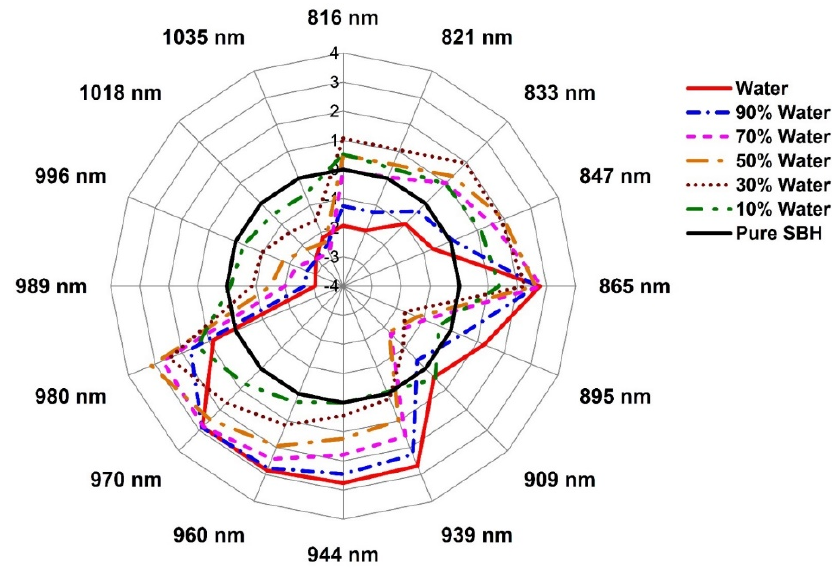
Figure 8. Aquagrams of pure SBH, water, and adulterated SBH with various percentages of water.